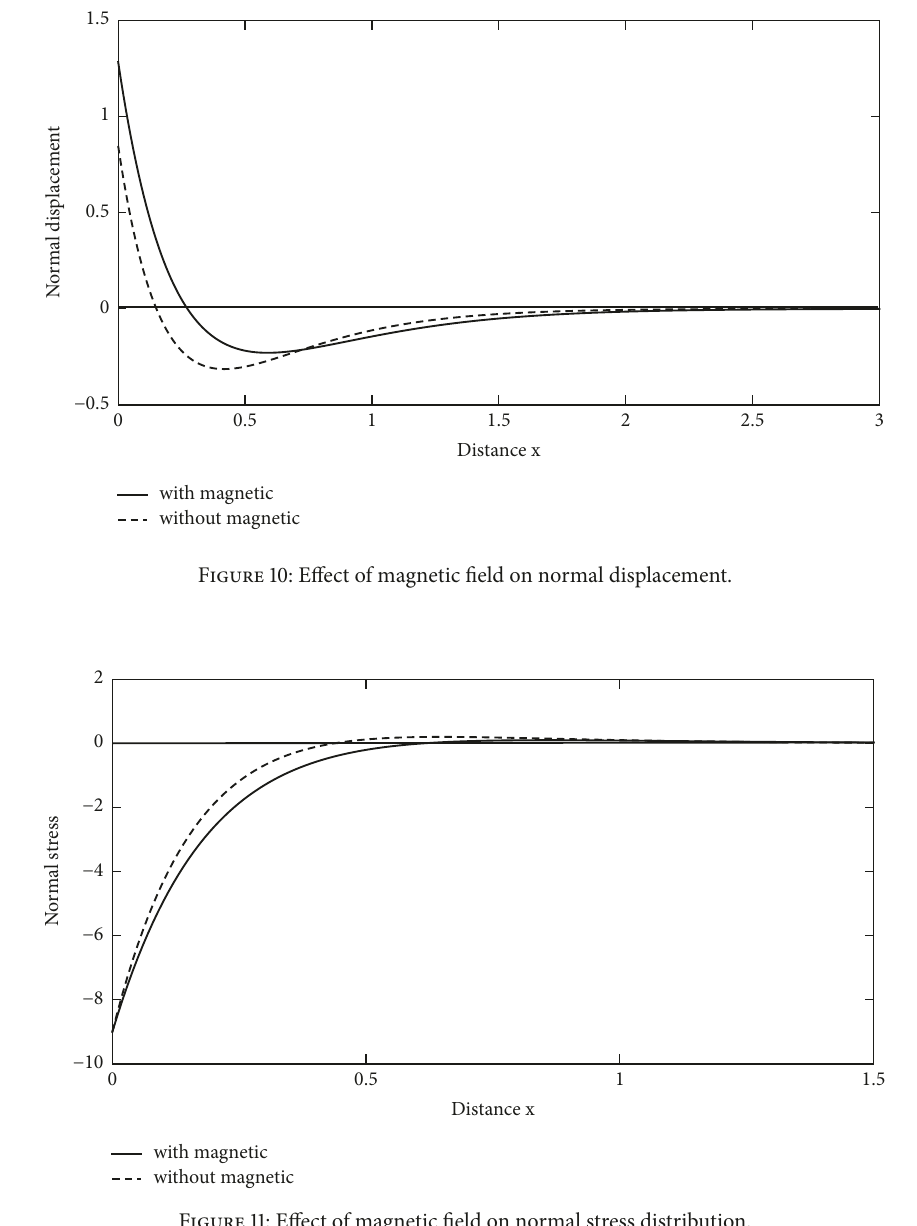
Figure 11: Effect of magnetic field on normal stress